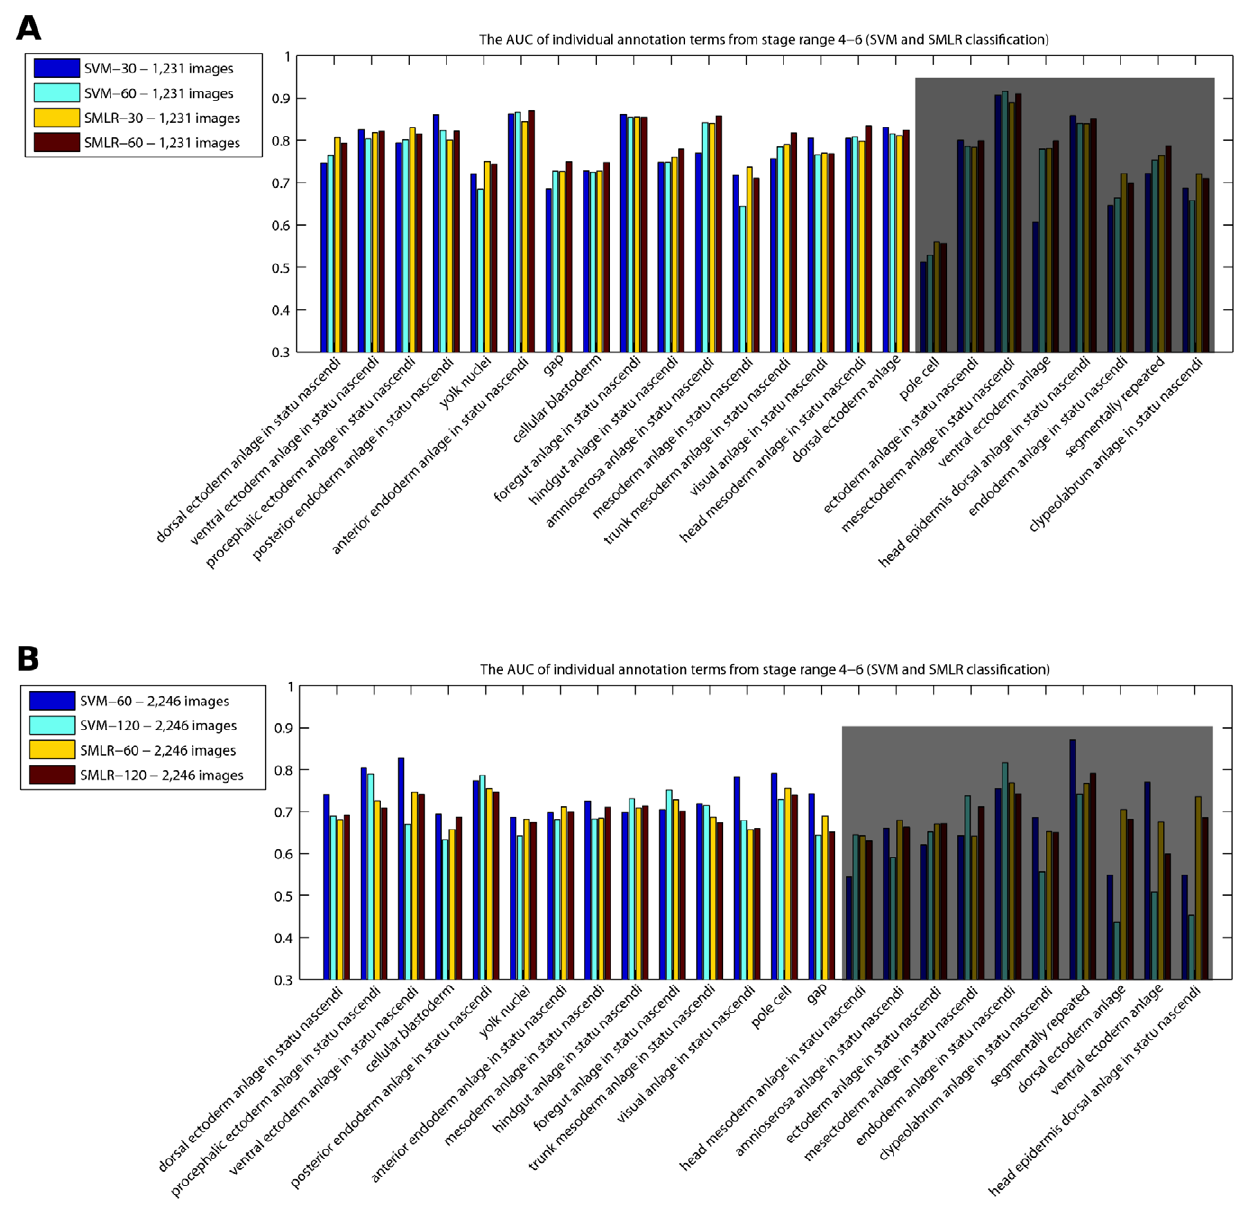
Figure 8. SMLR and SVM comparison on (A) data set S l and (B) data set S 4 { 6 : the AUC of individual annotation terms from the 4 { 6 time window of developmental stages 4–6. (A) We consider two different scenarios: using the factors corresponding to the highest resolution, k ~ 30 (SVM- 30 and SMLR- 30 ), or using the entire set of factors available (SVM- 60 and SMLR- 60 ). The last 8 annotation terms correspond to 15 genes or less, too few to count for a strong statistical evaluation (shaded area). (B) We consider two different scenarios: using the factors corresponding to the highest resolution, k ~ 60 (SVM- 60 and SMLR- 60 ), or using the entire set of factors available (SVM- 120 and SMLR- 120 ). The last 10 annotation terms correspond to 20 genes or less, and results are less reliable due to the stronger variance and impact of results on individual samples (shaded area).